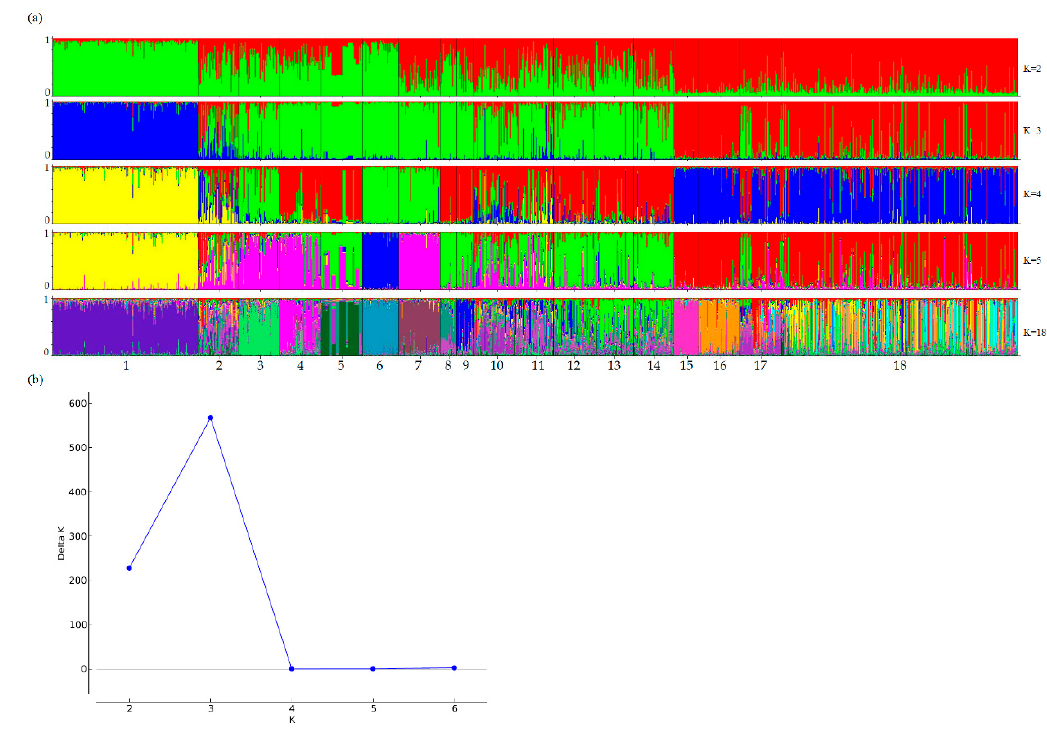
Figure 2. Results of Structure analysis based on microsatellite data: ( a ) proportion of membership of each animal to K assumed clusters (K = 2–5, 18). Breed numbering: Holst (1), Tagil (2), Kholm (3), RedGor (4), BrSwis (5), Grey(6), Yaros (7), Kostr (8), Altai (9), Kalm (10), AulieAt (11), Alatau (12), KyrgBT (13), KyrgNat (14), Yakut (15), Khogor (16), Gobi (17), and Buryat (18); ( b ) values of the statistic Δ K calculated by the method proposed by Evanno et al. for K = 1–7.